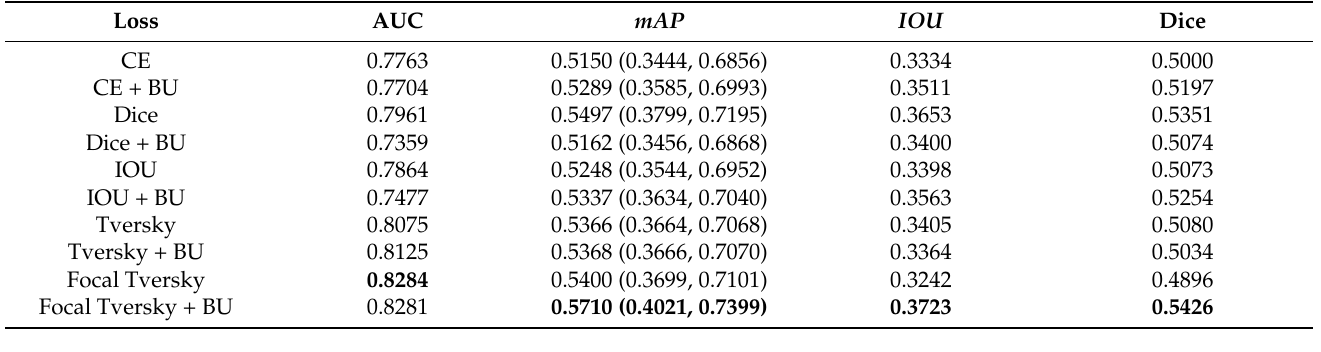
Table 2. Test performance achieved by the VGG-16-based U-Net model trained with the proposed loss functions. Bold numerical values denote superior performance. Values in parenthesis denote the 95% CI for the mAP metric.